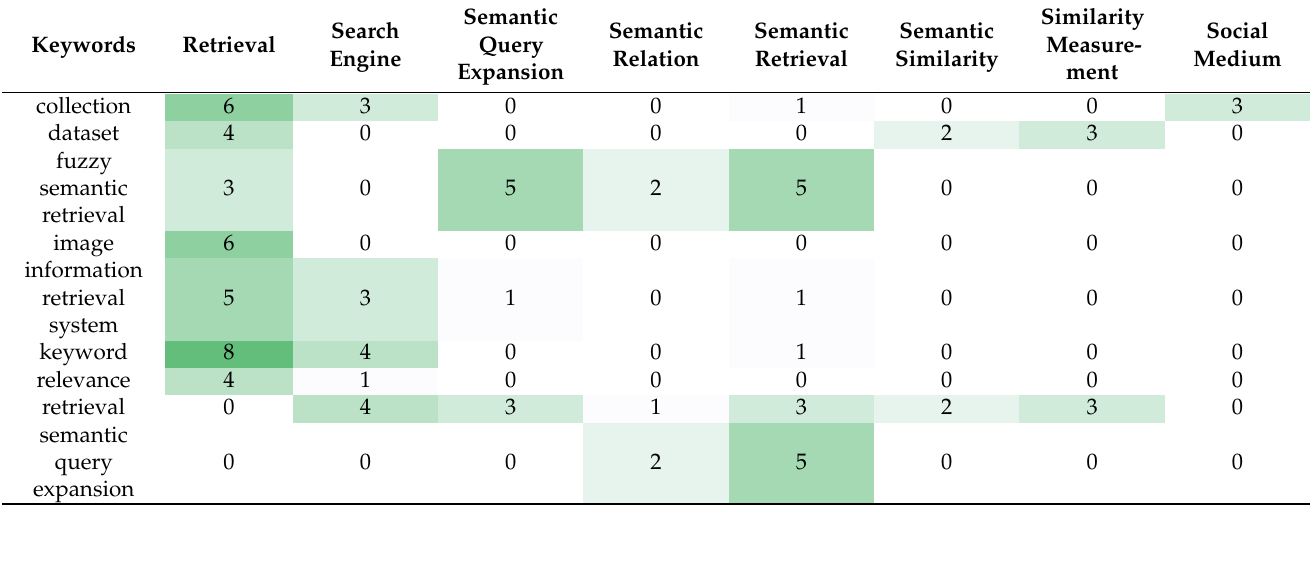
Table 3. The co-occurrence matrix of the moderately occurring keywords in the ontology- and fuzzy-based IS field (the whole co-occurrence matrix is presented in GitHub (https://github.com/Jolantux13/Onto_Fuzzy_IS (accessed on 25 February 2021)).